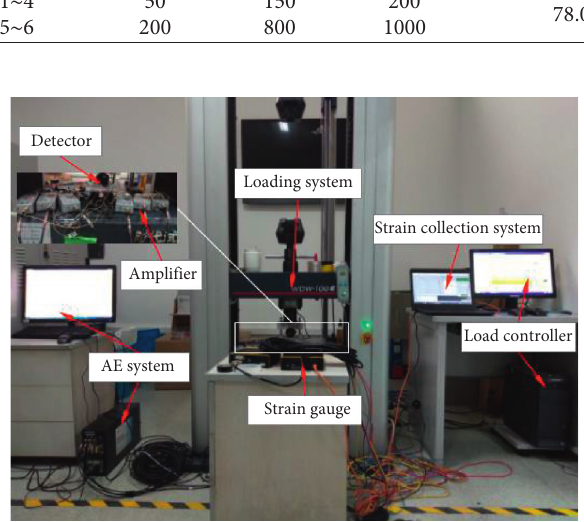
Figure 7: WDW-100E universal testing machine and AE system.